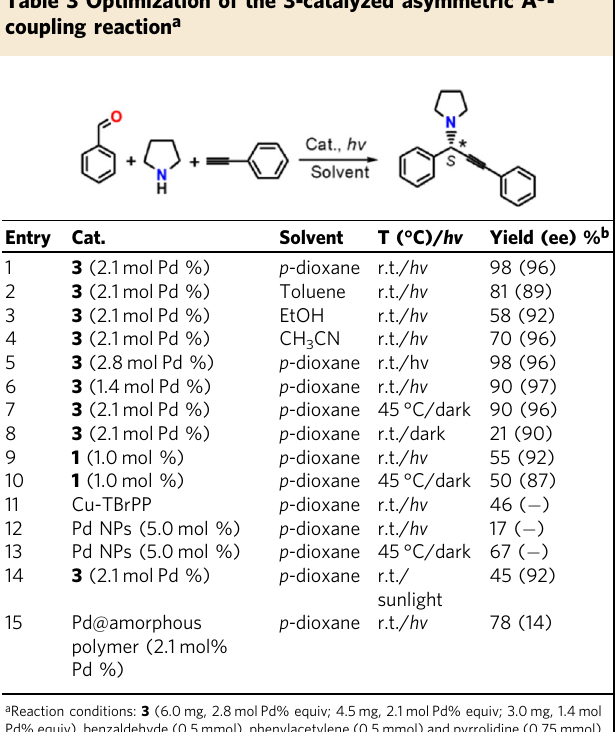
Figs. 21 and 22). Thecomparison of 3 with reported asymmetric A 3 -coupling reaction was shown in Supplementary Table 5. 3 herein met excellent yield and stereoselectivity, mild